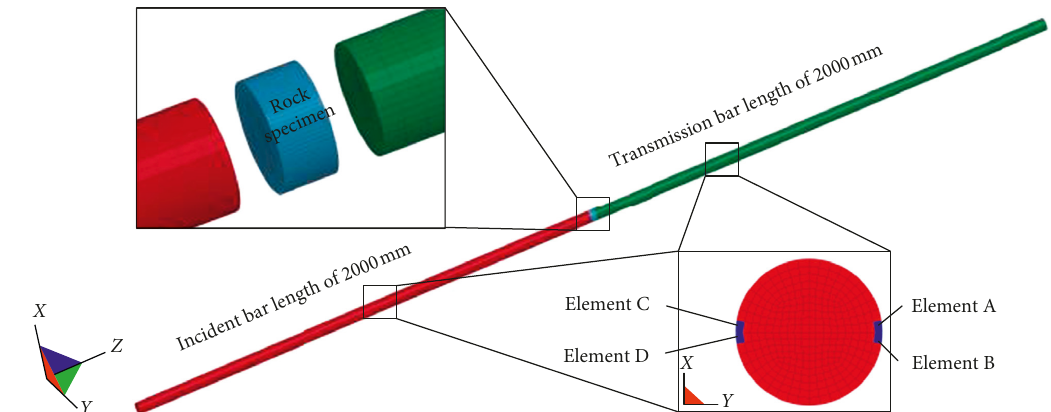
Figure 2: Three-dimensional numerical model including incident bar, transmission bar, and rock specimen. Table 1: Material parameters for HJC model of rock material with Young’s modulus of 14 GPa. ρ (g/cm 3